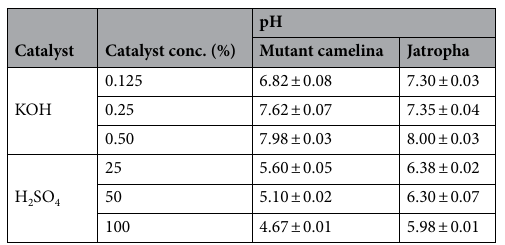
Table 2. pH of biodiesel produced from mutant camelina and jatropha.